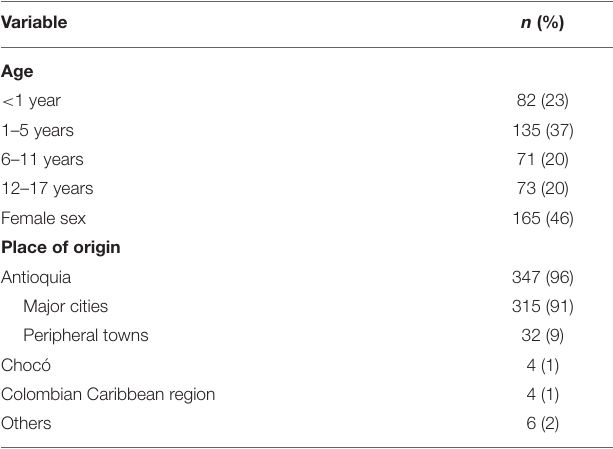
TABLE 1 | Demographic characteristics of all the patients.